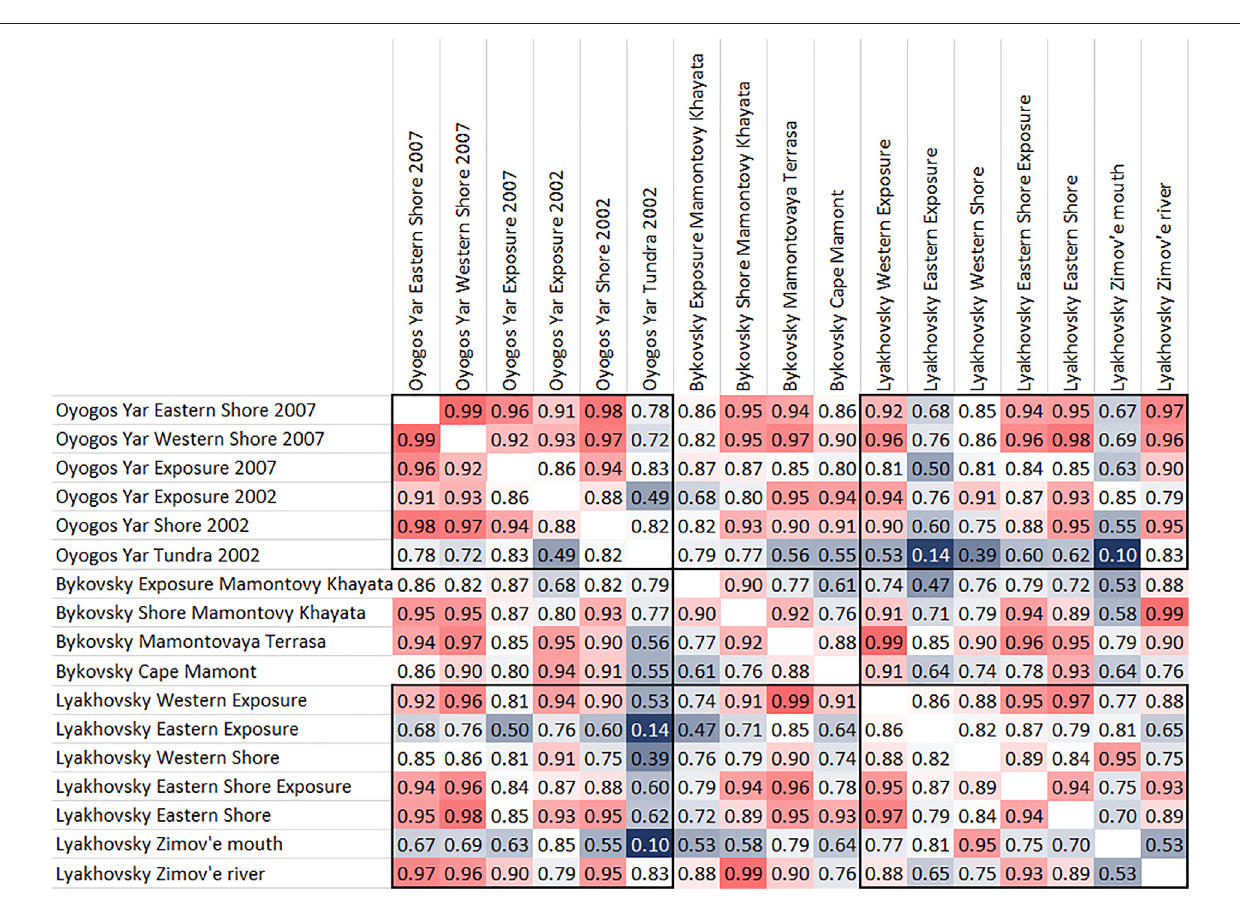
Frontiers in Earth Science |